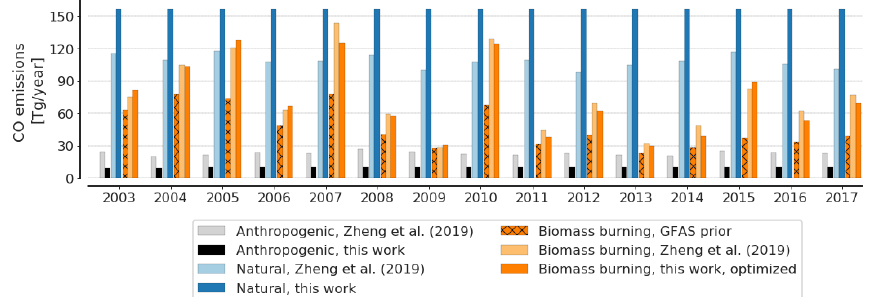
Figure 9. Emission totals for different source categories from this work, compared to emissions from Zheng et al. (2019). Total CO emissions are summed over the 1 ◦ × 1 ◦ South American zoom domain as well as over the April–December inversion period. For bars corresponding to this work, emissions from our standard inversion are shown (i.e. GFAS fire emissions optimized with MOPITT-retrieved CO columns) as well as emissions from a global MOPITT inversion performed by Zheng et al. (2019). Emission categories from Zheng et al. (2019) were merged to obtain emission categories comparable to